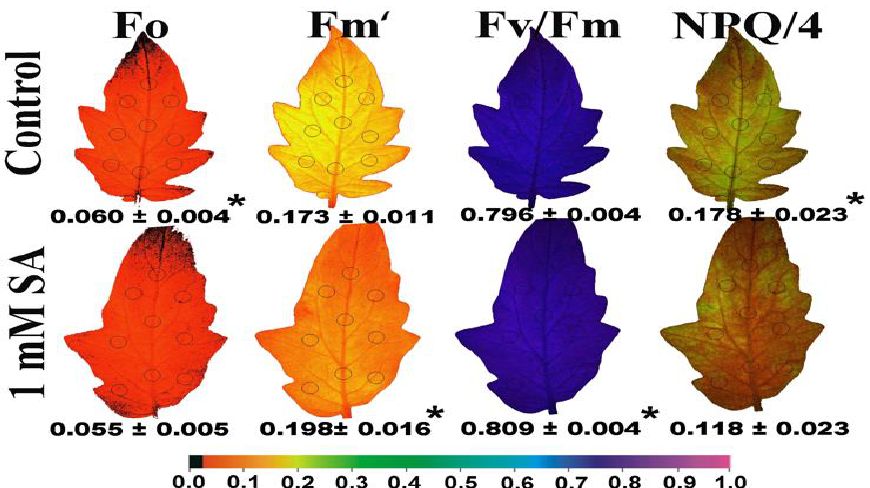
Figure 4. Representative color-coded images of the minimum chlorophyll a fluorescence in the dark (F o ), the maximum chlorophyll a fluorescence in the light (F m ‘ ), the maximum efficiency of PSII photochemistry (F v /F m ), and the non-photochemical quenching (NPQ), depicted as NPQ/4, of tomato leaflets, after 72 h of foliar spray by either distilled water (control) or 1 mM salicylic acid (SA). The areas of interest (AOI) are shown in circles and the resulting values for each chlorophyll fluorescence parameter for the whole leaflet (average ± SD) are given for the dark adaptive state or under 205 μmol photons m − 2 s − 1 corresponding to low light intensity (LL). The color code showed at the bottom ranges from values 0.0 to 1.0. An asterisk indicates statistically significant difference ( p < 0.05) between the control and 1 mM salicylic acid (SA) treatment.